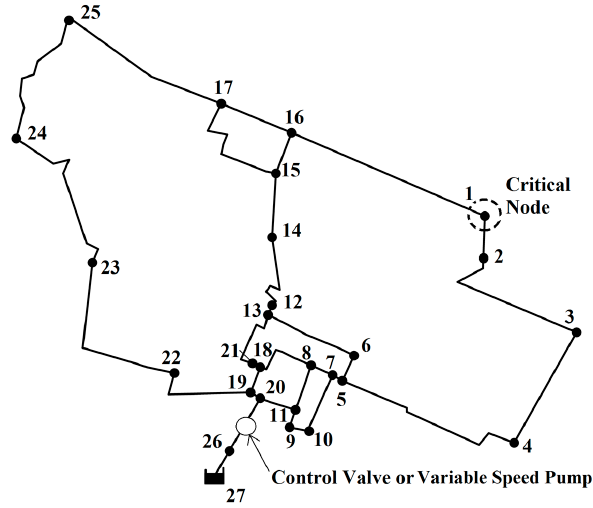
Figure 3. Water distribution network considered for the applications.